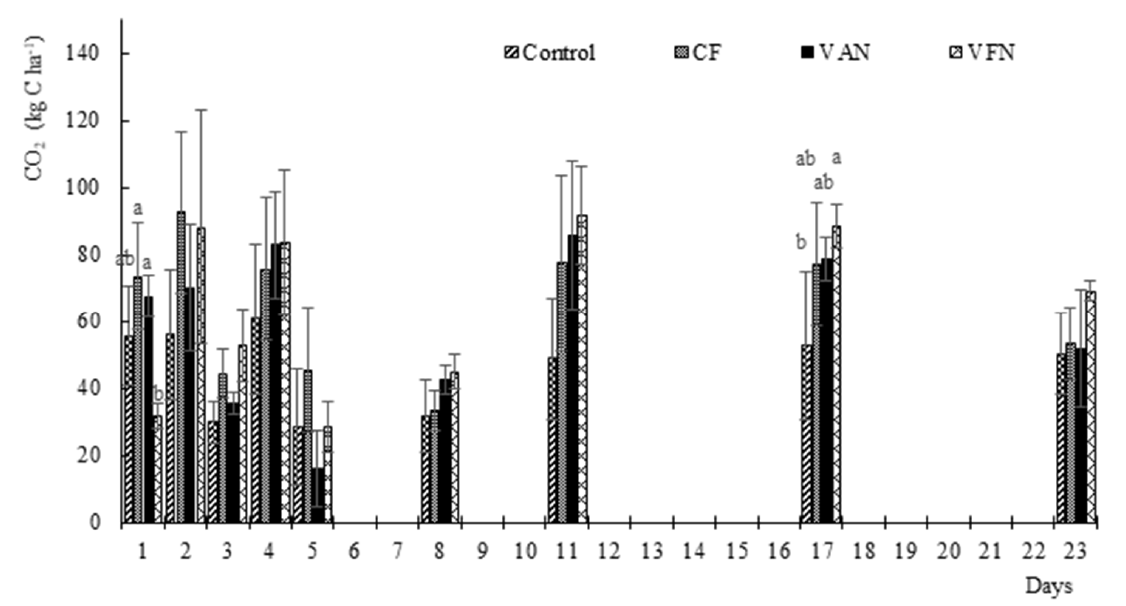
Figure 2. CO 2 emission dynamics (kg CO 2 -C ha − 1 ) for barley in season 2018/2019. Different letters indicate significant difference, according to Dunn’s post-hoc test ( p < 0.05), between treatments.